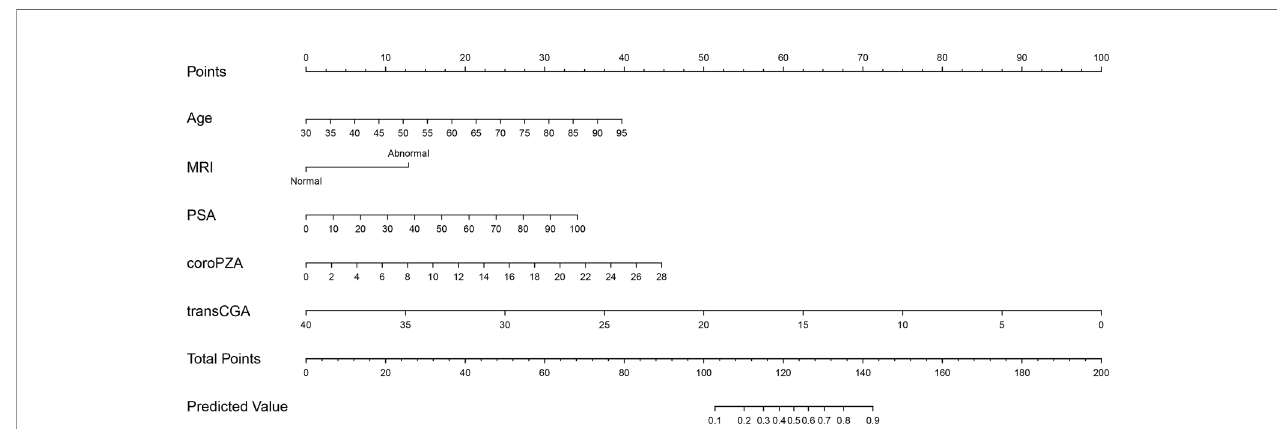
FIGURE 4 | Nomogram predicting the probability of PCa at the initial biopsy based on model 1.